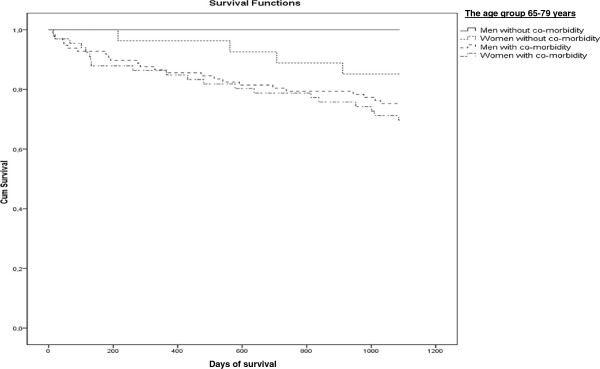
Kaplan-Meier plot: Days of Survival up to 3 Years (1096 days) in the Age group 65–79 years by Gender and with or without Co-morbidity (elevated Charlson Index or not).